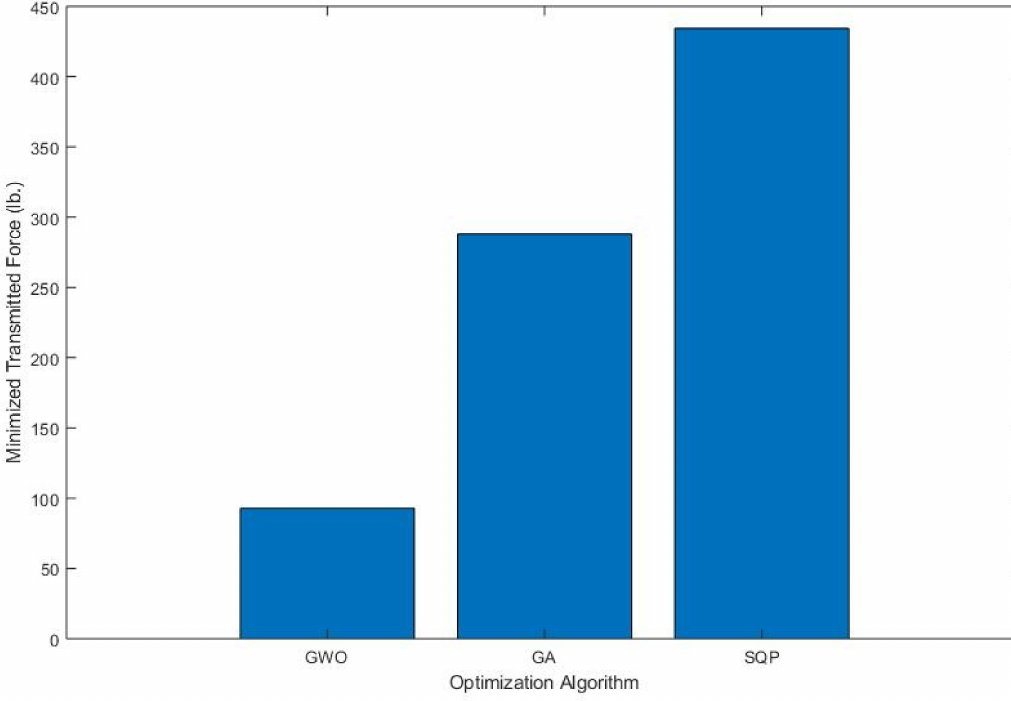
Figure 18. Minimized transmitted force for the 12-DOF model (combined